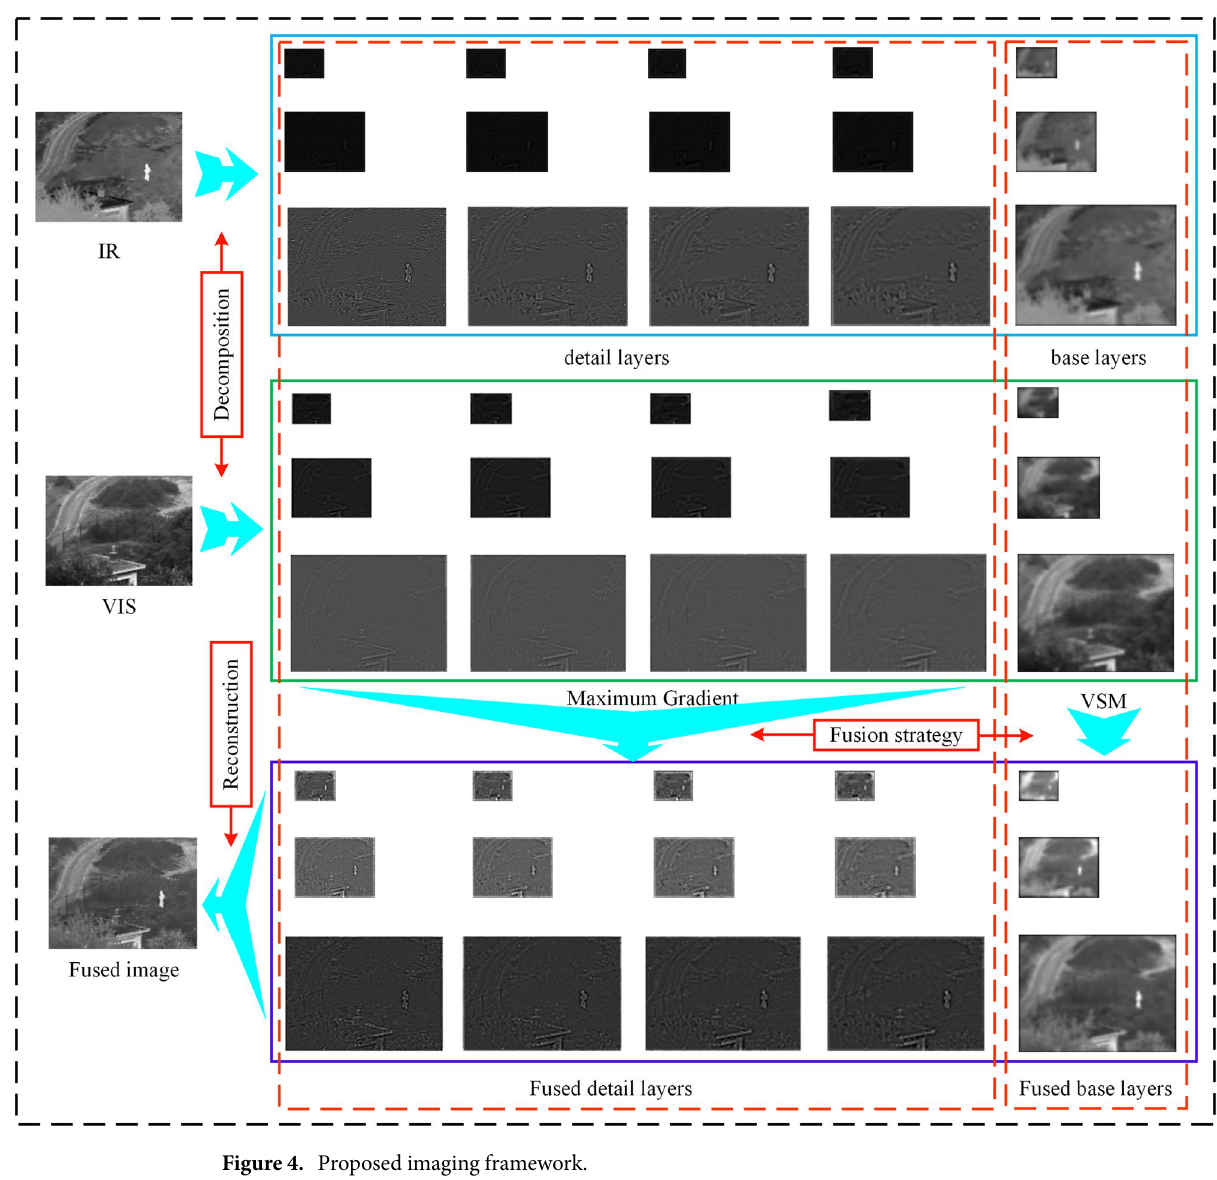
Figure 4. Proposed imaging